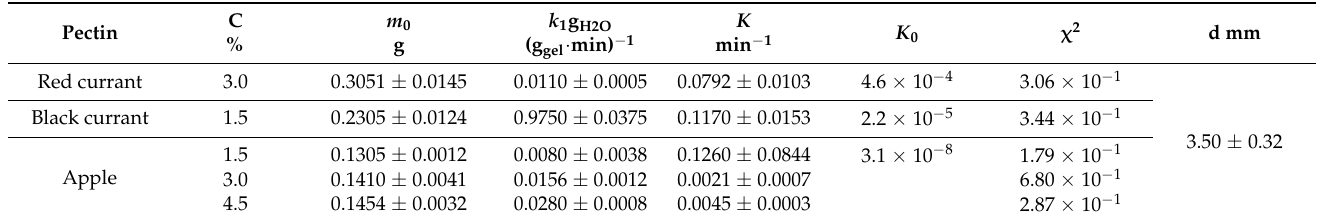
Table 2. Swelling properties of beads prepared from pectins obtained from different